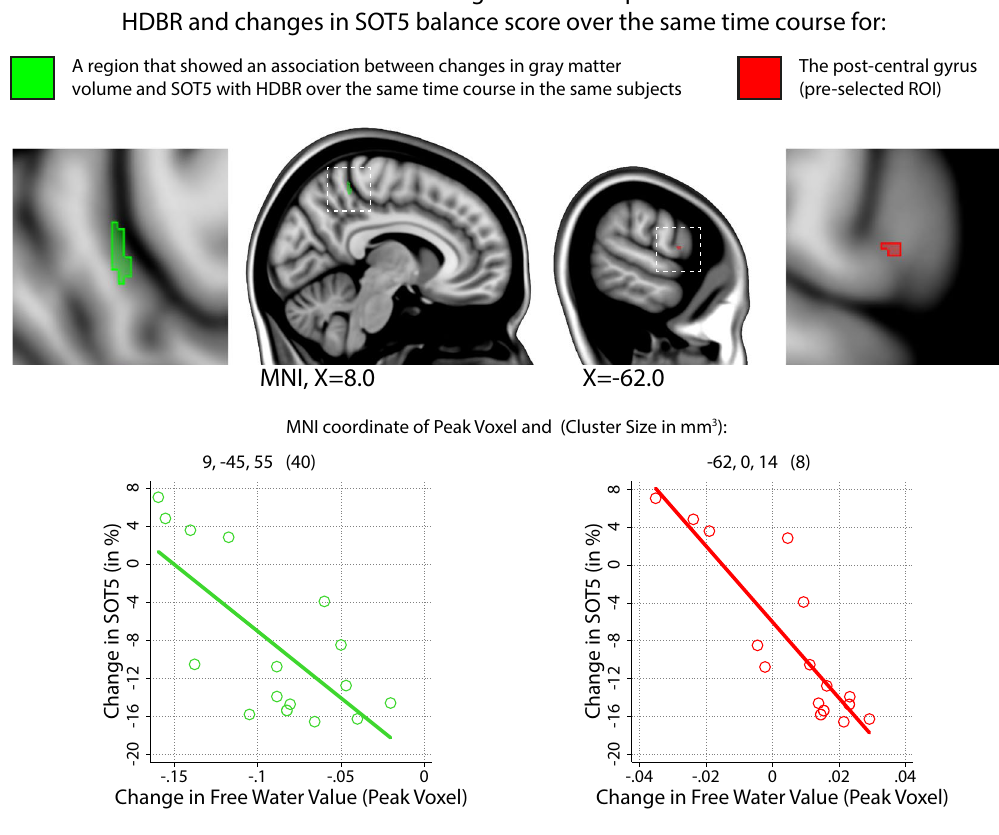
Figure 4. Correlations between changes from pre-HDBR to the end of HDBR in Free Water and Balance. Change in balance performance (SOT5) was negatively correlated with FW changes in two predefined regions of interest: 1) a region covering the precuneus (green accents); and 2) the lateral post-central gyrus (red accents); Graphs show the direction of the association. I.e., decreases in FW result in smaller balance decrements or even improvements from pre-HDBR to the end of HDBR whereas larger FW increases result in larger balance deterioration. SOT5 = Sensory Organization Test 5; MNI = Montreal Neurological Institute. All results are corrected for multiple